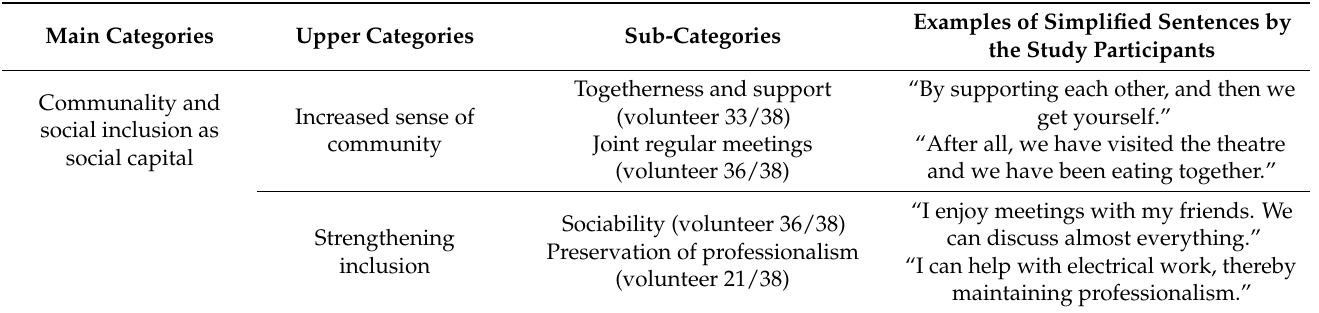
Table 4. Communality and social inclusion as social